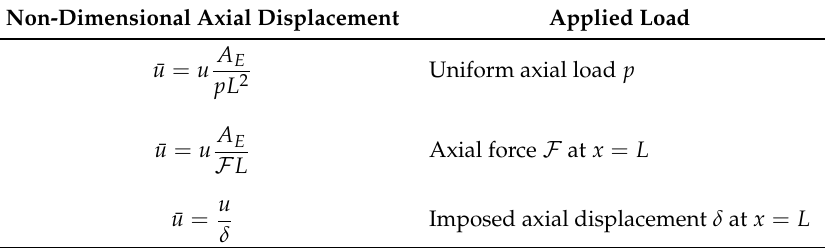
Table 2. Non-dimensional axial displacement ¯ u in terms of the applied